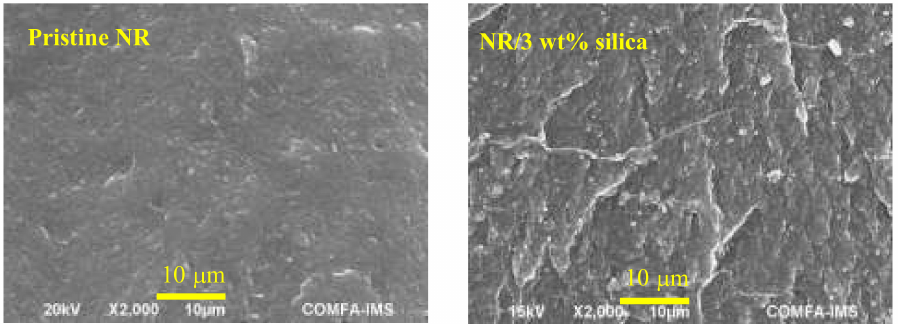
Figure 7. SEM images of the fracture surface of pristine natural rubber and 3 phr silica filled natural